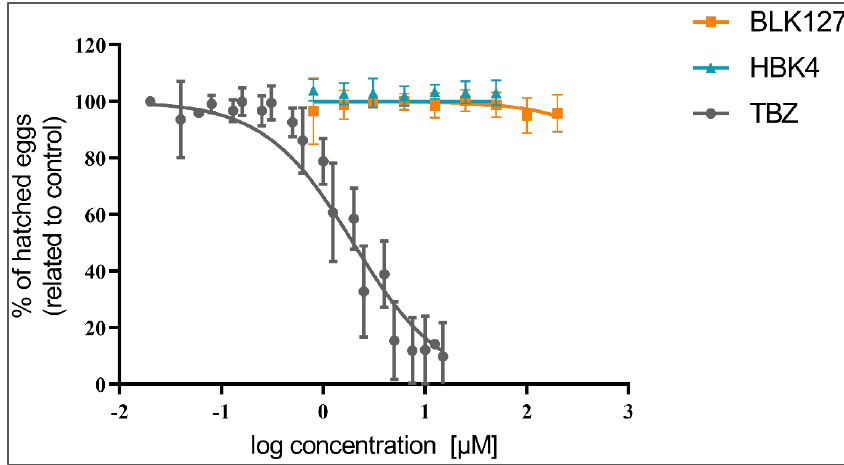
Figure 1. Effect of compounds BLK127, HBK4 and TBZ on H. contortus egg hatching (ISE strain) in comparison to a negative (no-compound) control (0.5% v / v DMSO). The data are presented as a means ± SD ( n = 5).